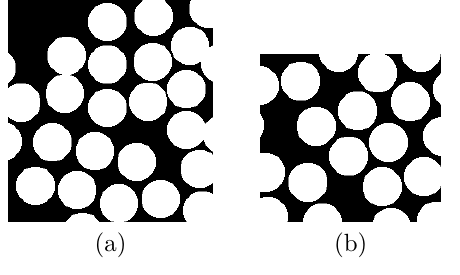
Figure 15. Carbon cell: a) minimal stiffness, b) maximal stiffness.